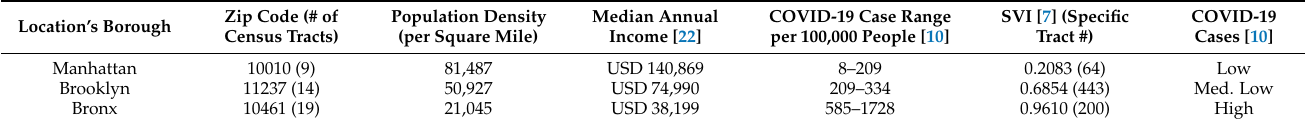
Table 2. Comparison of demographics and COVID-19 rates in selected locations.